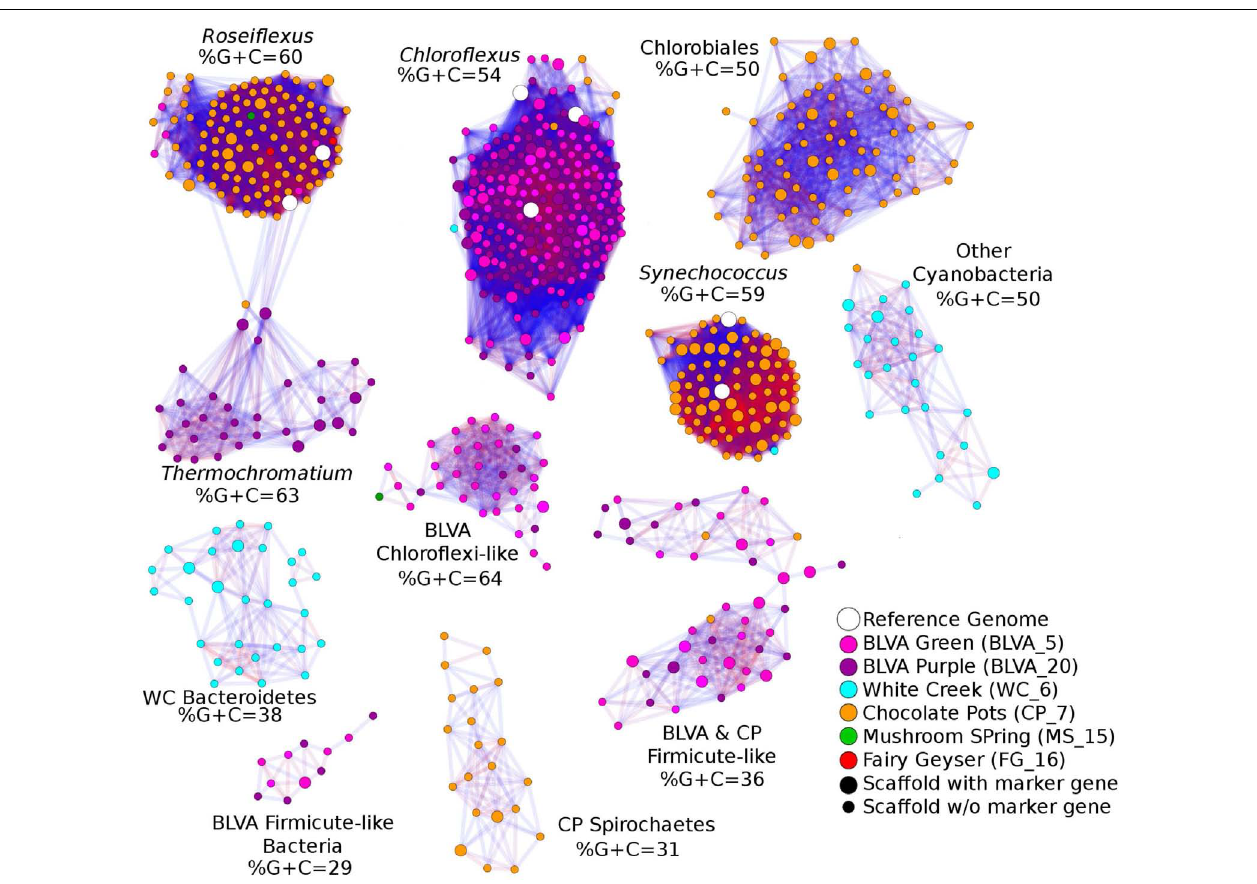
connecting scaffolds ranging from blue (90%) to red (100%).The sample origins of scaffolds shown here are indicated by site color (see legend) where open circles correspond to reference genomes; scaffolds containing phylogenetic or functional marker genes are indicated by larger nodes.